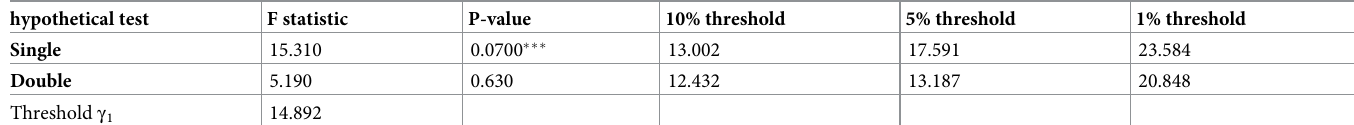
Table 8. Agricultural insurance per capita threshold effect of indemnity test result. hypothetical test